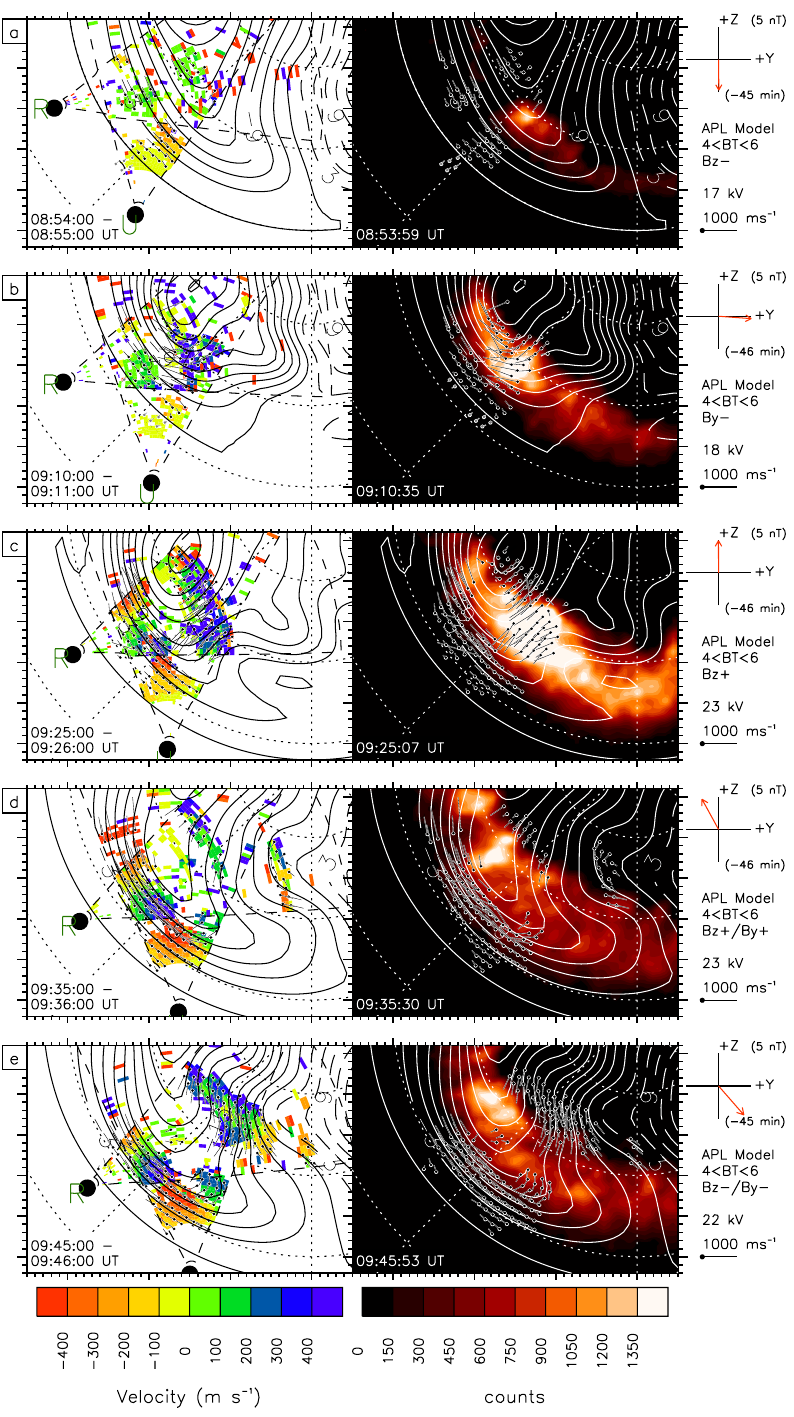
Fig. 4. Two-dimensional maps of the ionospheric flows and auroral images from selected times over the interval spanning the substorm. The times of the radar scans are indicated in the bottom left-hand corner of each panel. Superposed on the line-of-sight radar data (left hand panels) are the electric equipotentials from the Map Potential analysis, shown at 3kV intervals, and the two dimensional fitted flow vectors. The accompanying auroral images (right hand panels) are those which most closely correspond to the times of the radar scans, their exact times being shown in the bottom left-hand corner of each image. On the far right, parameters from the Map Potential analysis (see Sect. 2) are shown, including the concurrent (lagged) IMF vector, the APL statistical model used and voltage across the 21:00 MLT auroral zone from Fig.